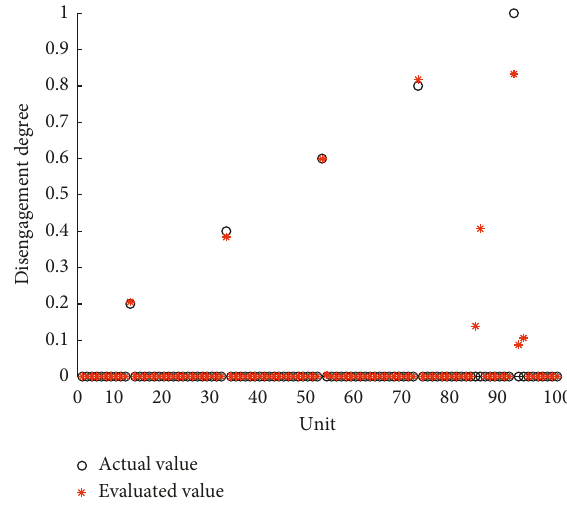
Figure 9: Estimation result of CMDEA with German low-dis- turbance